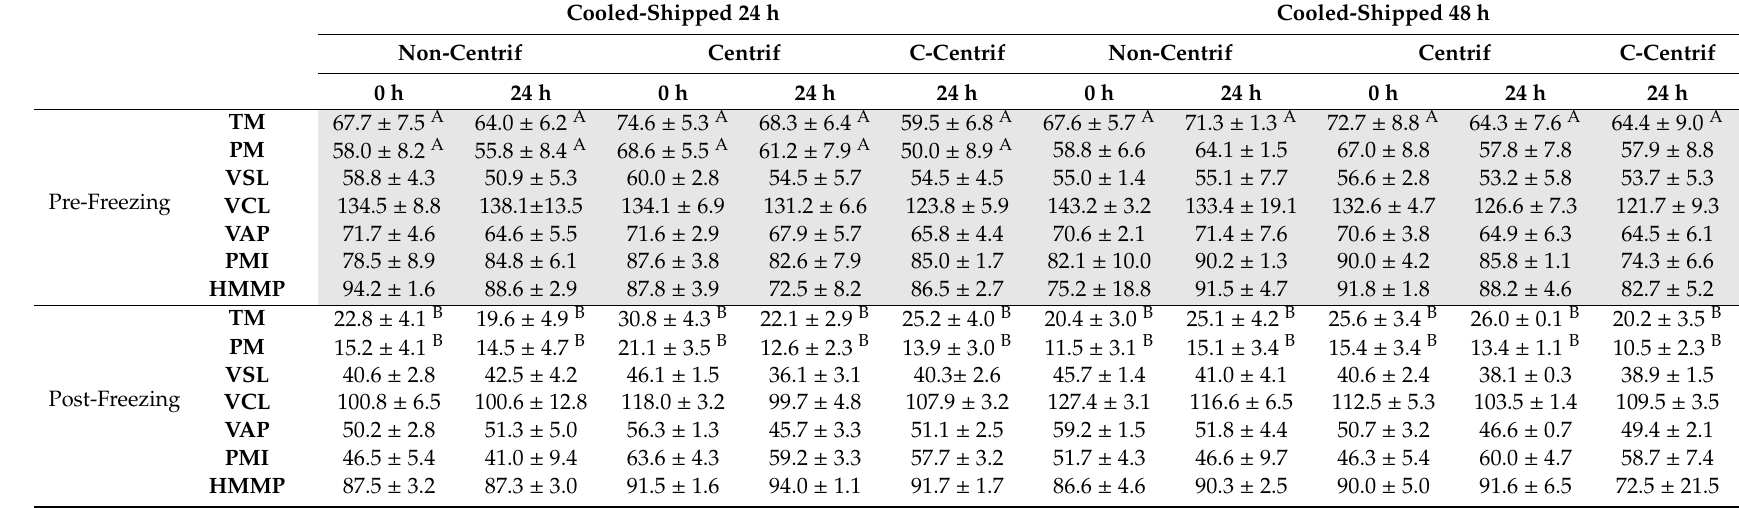
Table 4. Pre- and post-freezing parameters of the epididymal semen obtained from donkey cooled-shipped epididymides attached to the testes. All epididymides were kept in the passive cooling device until processing. The epididymides were processed upon arrival ( n = 8 pairs) ( cooled-shipped 24 h ) or the following day ( n = 6 pairs) ( cooled-shipped 48 h ). One epididymis of each pair was submitted to retrograde flushing with a semen freezing egg yolk-based extender (EY), while the contralateral was flushed with a cooling extender based on sodium caseinate cholesterol-loaded cyclodextrin (SC). Thereafter, the semen extended in EY was frozen immediately after recovery ( Non-Centrif-0 h ) or cooled for 24 h and then frozen ( Non-Centrif-24 h ). The semen extended in SC was cushion-centrifuged, resuspended in EY and then frozen ( Centrif-0 h ); or cooled for 24 h before being frozen ( Centrif-24 h ); or cushion-centrifuged, re-extended with SC, and then cooled for 24 h, re-centrifuged and extended in EY and then frozen ( C-Centrif-24 h ). Data are expressed as mean ±